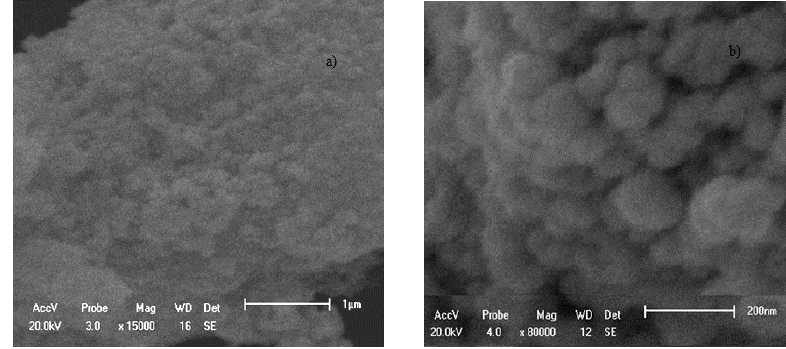
Figure 2. SEM image of the bimodal silica showing particle aggregates ( a ) and the particle distribution ( b ).